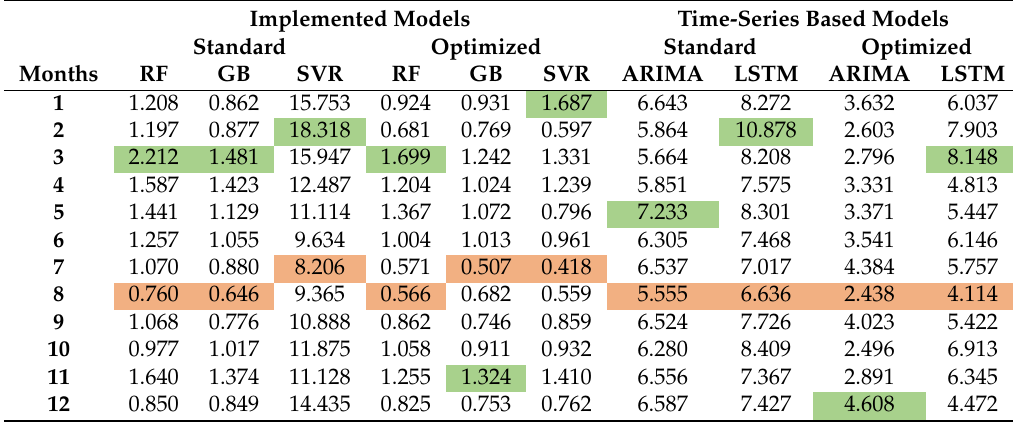
Table 7. MAPE (%) monthly over the test data (2018) for all the evaluated models with default (non-optimized) parameters against the optimized (tuned) pipelines.